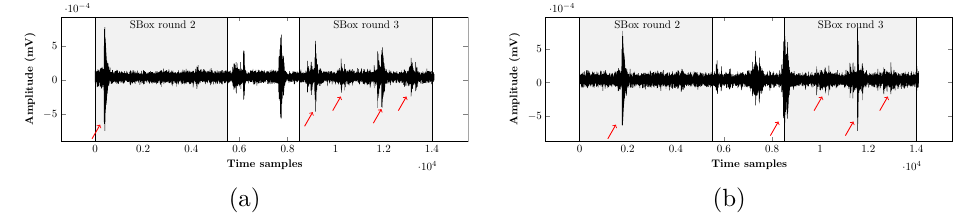
Figure 2: Differential power trace showing leakage at Sbox in round 2 and round 3 of AES -128 on 32-bit ARM microcontroller. Highlighted parts show how (a) difference in the first byte and (b) difference in the second byte propagates into 4 bytes.